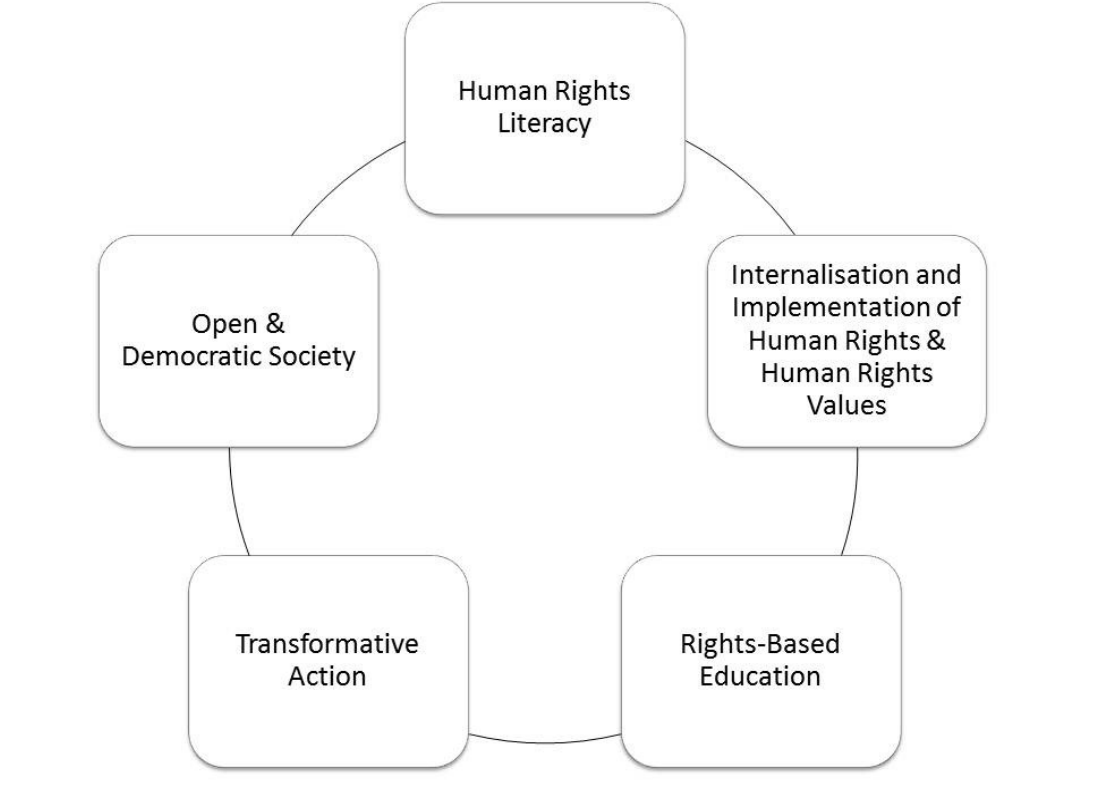
Figure 1 Human rights literacy: Moving towards an open and democratic society through